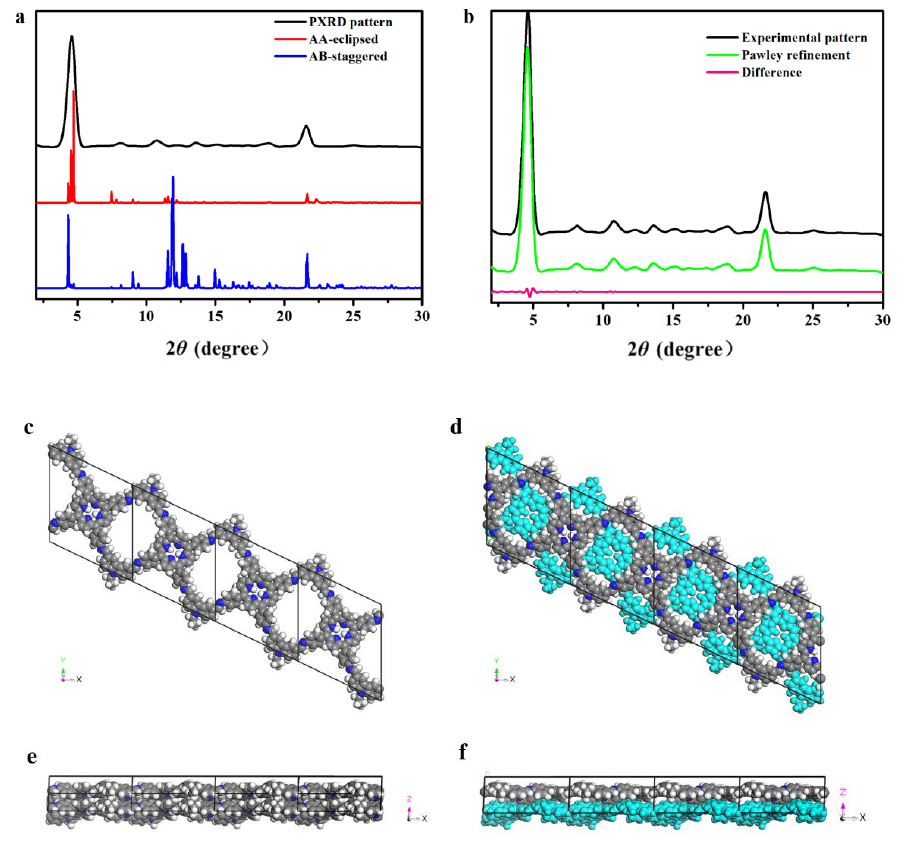
Figure 2. ( a ) Experimental PXRD pattern (black curve) and the simulated patterns according to AA-eclipsed (red curve) and AB-staggered (blue curve) stacking models; ( b ) Experimental PXRD pattern (black curve) and Pawley refinement (green curve) and difference between the experimental and refined patterns (pink curve) of COF-K; ( c ) Top view of the AA-eclipsed model structure of COF-K; ( d ) Top view of the AB-staggered model structure of COF-K; ( e ) Side view of the AA-eclipsed model structure of COF-K; ( f ) Side view of the AB-staggered model structure of COF-K . To investigate the porosity and BET surface area of COF-K, the nitrogen adsorption-desorption isotherm was measured at 77 K after degassing at 120 °C for 12 h. As shown in Figure 3a, the isotherm of COF-K showed a Type-I isotherm feature according to the IUPAC classification and a steep